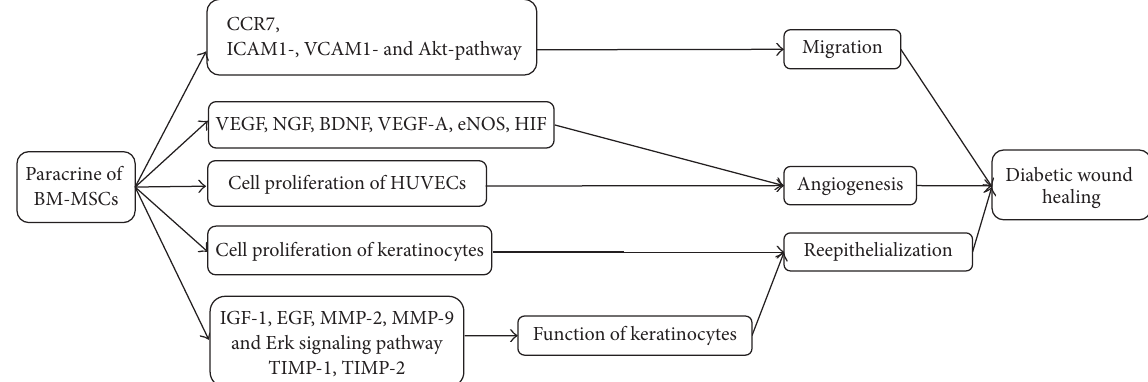
Figure 1: Mechanism of BM-MSCs for treatment of DFU. BM-MSCs can migrate and adhere via CCR7, ICAM1-, VCAM1-, and Akt- dependent mechanism and enhance angiogenesis through increasing VEGF, NGF, BDNF, VEGF-A, eNOS, and HIF. Cell proliferation of HUVECs and keratinocytes plays significant role in angiogenesis and reepithelialization, respectively. Keratinocyte function is improved by regulating IGF-1, EGF, MMP-2, MMP-9, TIMP-1, TIMP-2, and Erk signaling pathway. CCR7: C-C chemokine receptor type 7, ICAM1: intercellular adhesion molecule 1, VCAM1: vascular adhesion molecule 1, VEGF: vascular endothelial growth factor, NGF: nerve growth factor, BDNF: brain-derived neurotrophic factor, VEGF-A: vascular endothelial growth factor A, eNOS: endothelial nitric oxide synthase, HIF: hypoxia inducible factor, IGF-1: insulin-like growth factor 1, EGF: epidermal growth factor, MMP-2: matrix metalloproteinase-2, MMP- 9: matrix metalloproteinase-9, TIMP-1: tissue inhibitor of metalloproteinase-1, and TIMP-2: tissue inhibitor of